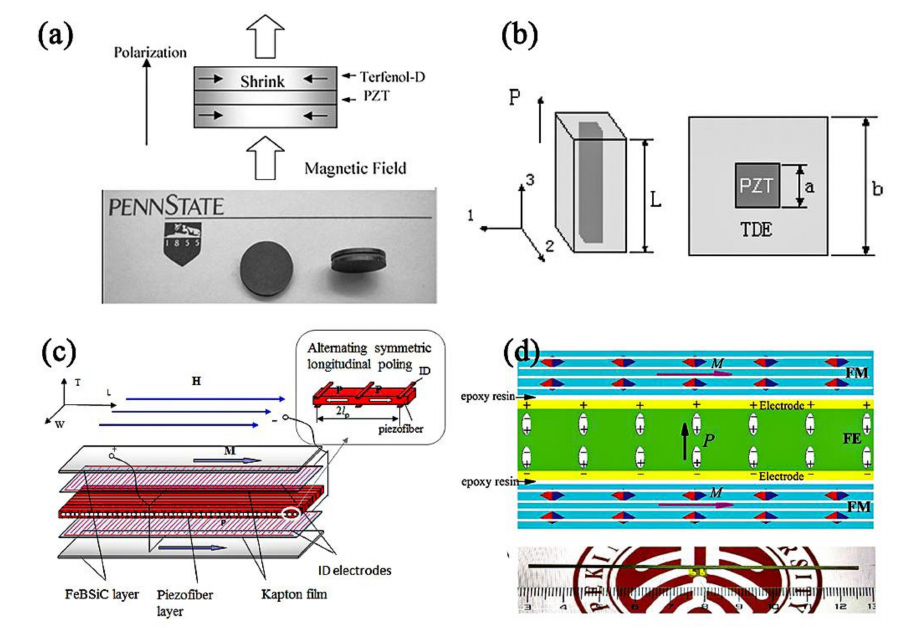
Figure 1. ( a ) Schematic structure (top) and photograph (bottom) of ME laminate composites using Terfenol-D and PZT disks [27]. ( b ) 3D and crosss ectional schematic illustration of the single period of 1-3-type ME structure [37]. ( c ) Illustration of the FeBSiC/piezofiber laminate configuration working on multi-push-pull mode [29,30]. ( d ) The schematic view for 1-1 laminated ME composite and a-(ii) the prototype snapshot of the 1-1 typed ME sample